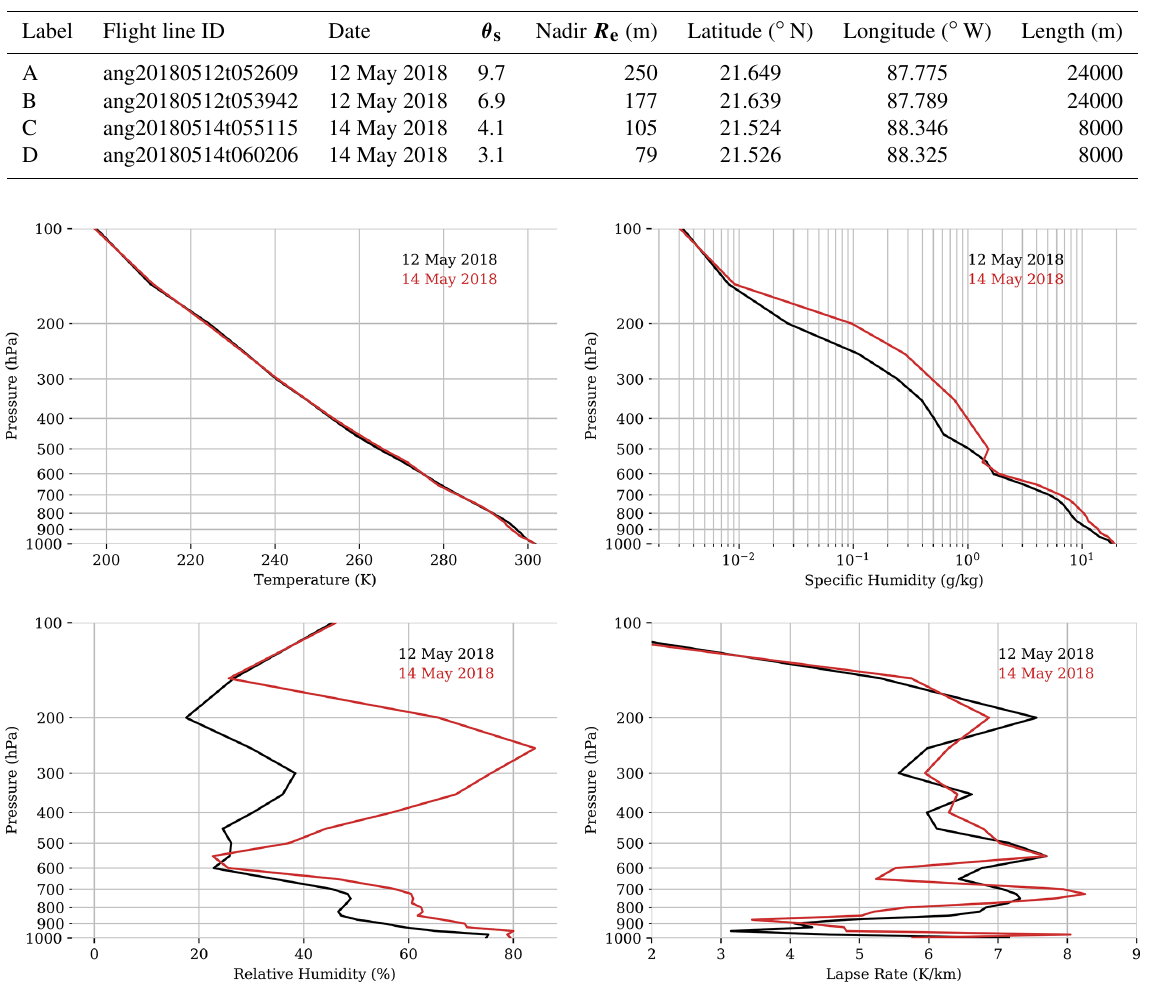
Figure 6. MERRA-2 reanalysis predictions for the 2 flight days. Counterclockwise from upper left: temperature, specific humidity, lapse rate, and relative